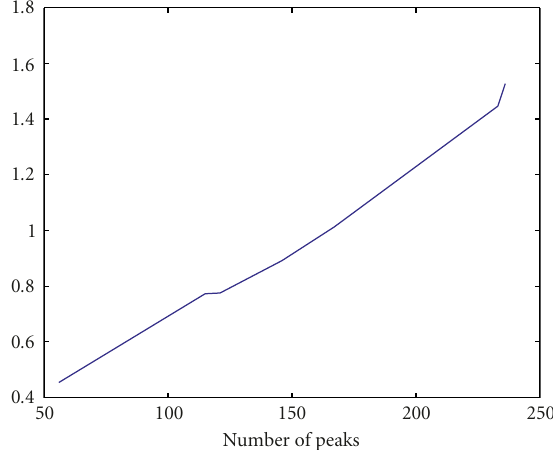
Figure 5: Mean reconstruction error as a function of the number of peaks for an increasing degree of peak